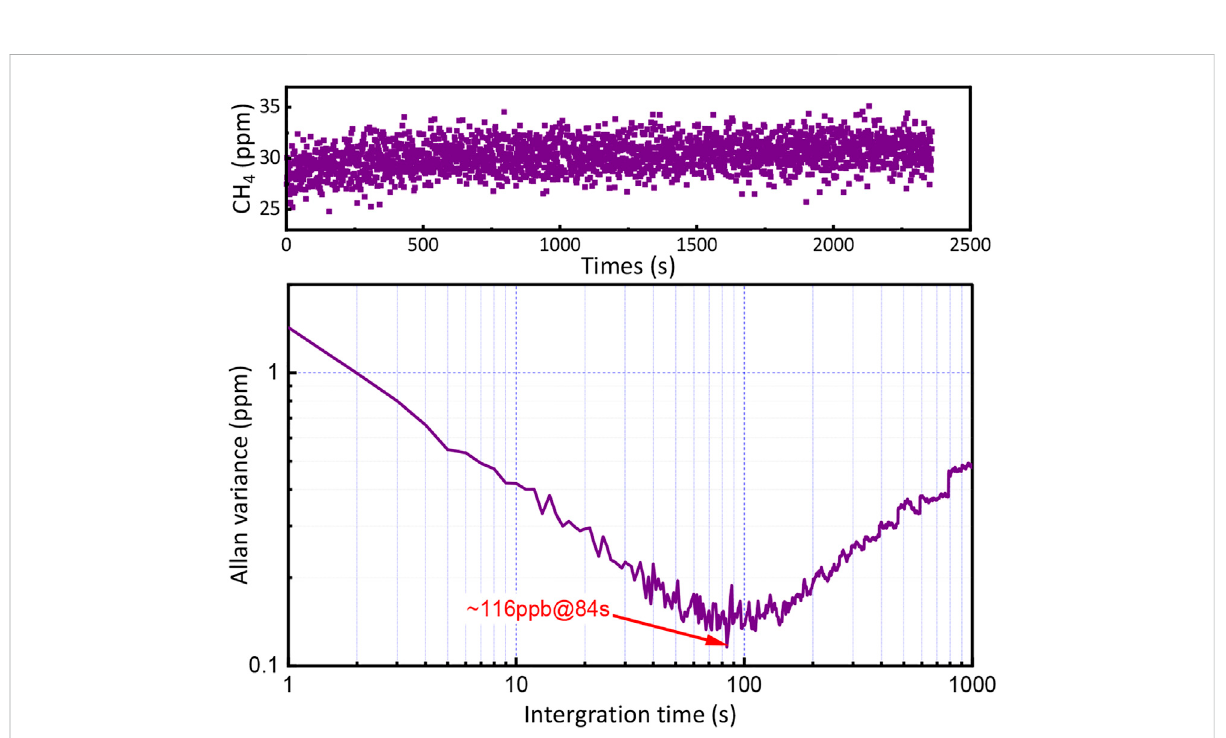
FIGURE 6 Row data of individual concentration measurements over 40 min (top) and Allan variance as a function of integration time